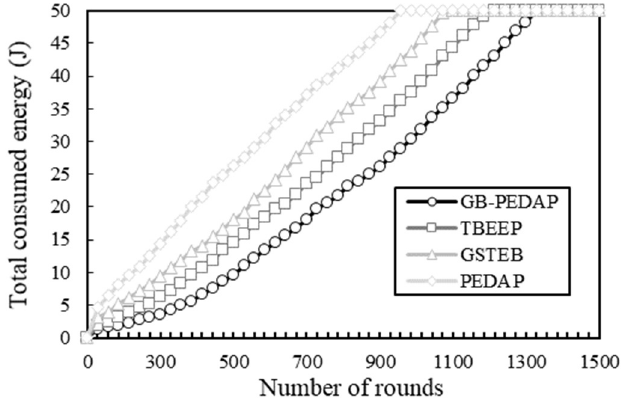
Figure 6. Total consumed energy under different numbers of rounds.